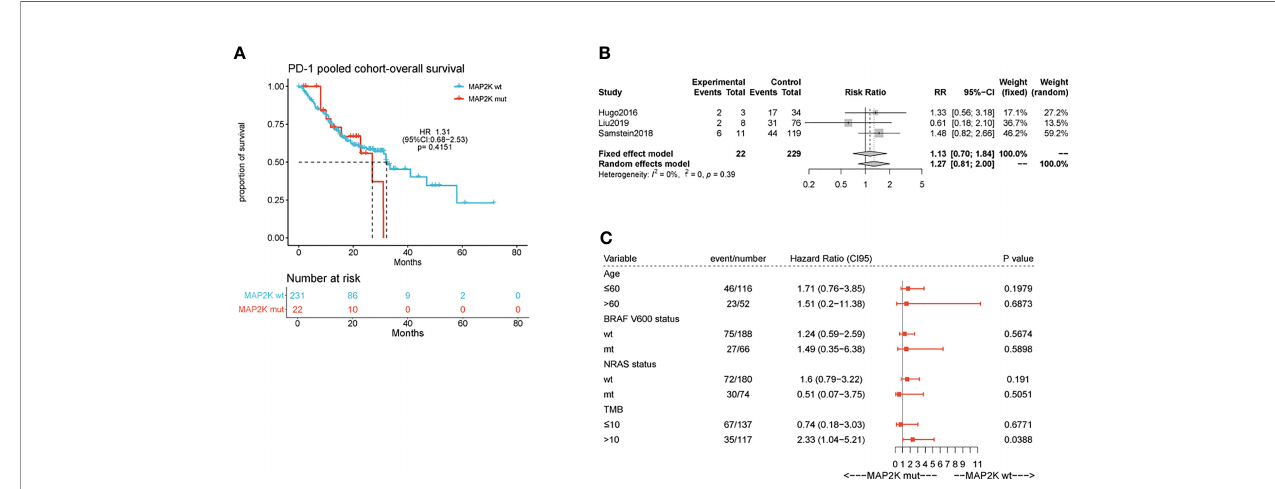
FIGURE 2 | Effect of MAP2K1/2 gene mutations on treatment response in anti-PD-1-treated melanoma. Kaplan-Meier analyses of overall survival (OS) in the anti- PD-1-treated cohort (A) . Pooled estimates of OS in three anti-PD-1-treated cohorts (B) . Subgroup Cox analysis of OS in pooled anti-PD-1 treated cohorts among patients with and without MAP2K1/2 gene mutations (C)